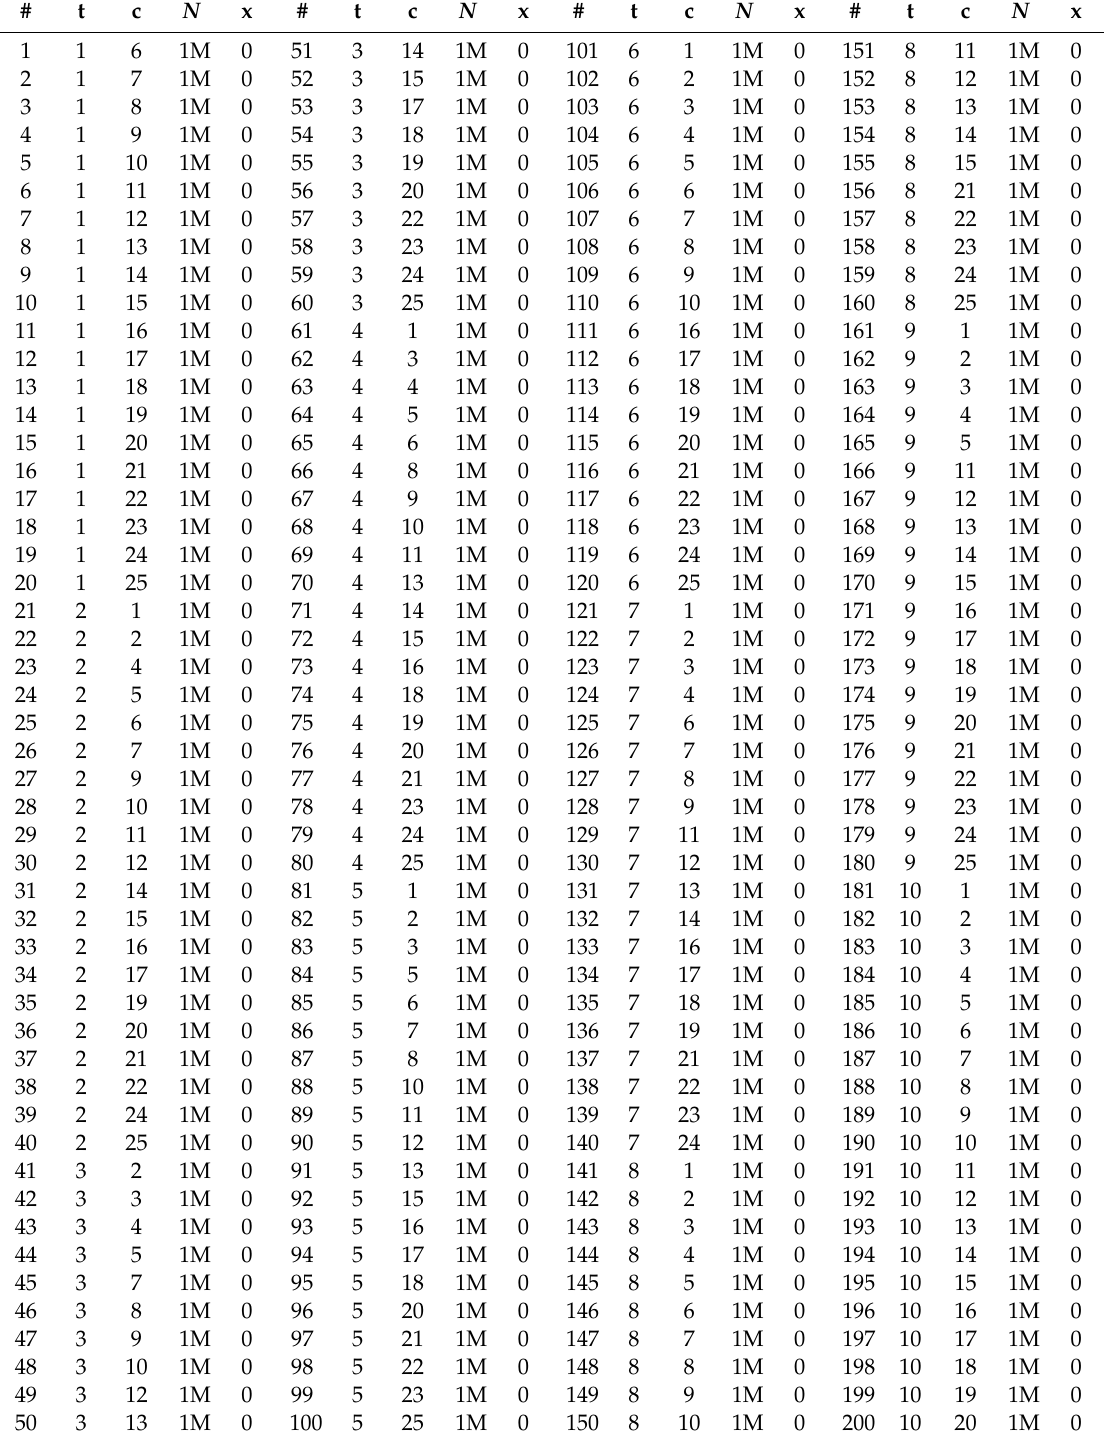
Table 3. The 200 high-level data points for the bar numerical example. This shows many zaps in the topic